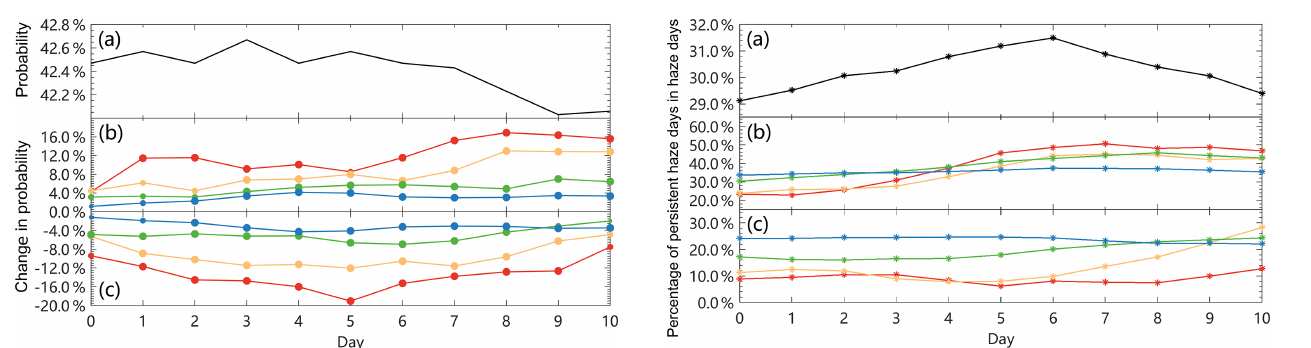
Figure 6. The probability of haze day at Day i ( i = 0...10) when (a) the state of the WNAO is unknown. The change in probability of haze day compared with (a) on the condition that (b) the 5d mov- ing average WNAO index is above the 95th (red), 90th (yellow), 75th (green) and 50th (blue) percentiles of the moving average se- ries and (c) the 5d moving average WNAO index is below the 50th (blue), 25th (green), 10th (yellow) and 5th (red) percentiles of the moving average series. The 5d moving average is the 5d sum of the WNAO index divided by five. Day 0 is defined as the last day of each consecutive 5d. The small, medium and large dots repre- sent the probability changes that are above the 90%, 95% and 99% confidence levels, respectively, for a Monte Carlo test with 10000 simulations.